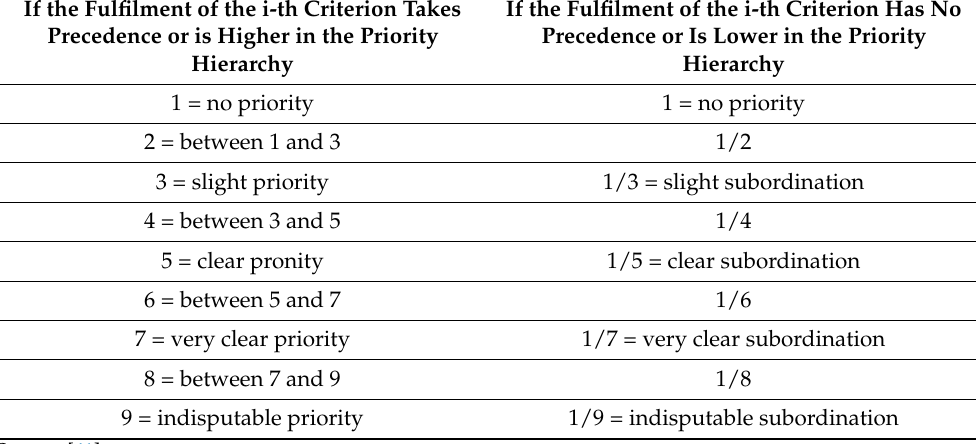
Table 1. Values that define the relationship between